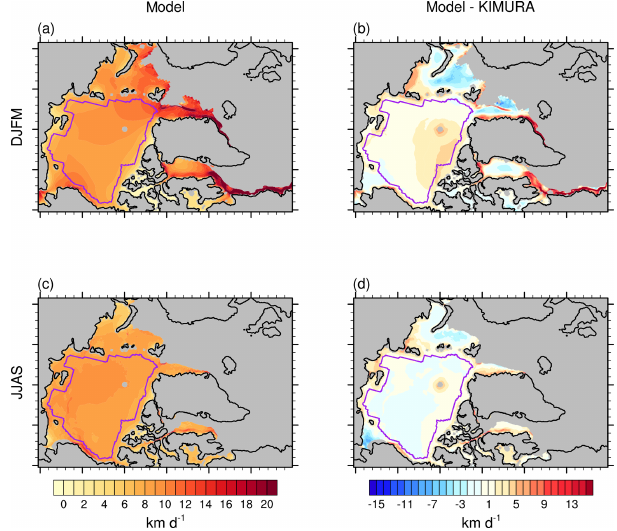
Figure 1. Mean spatial pattern of sea ice drift speed (kmd − 1 ) in the model (ensemble mean of HIRHAM–NAOSIM 2.0) for the 2003– 2014 (a) winter (DJFM) and (c) summer (JJAS). Panels (b) and (d) are the model differences to the observation (model − KIMURA) for winter and summer respectively. The purple line in each panel indicates the study domain used for the basin-wide